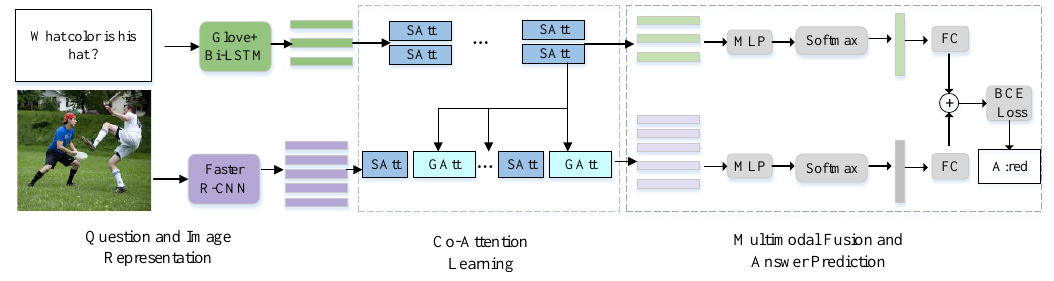
Figure 2. Overall flowchart of the improved dense multimodal co-attention network.